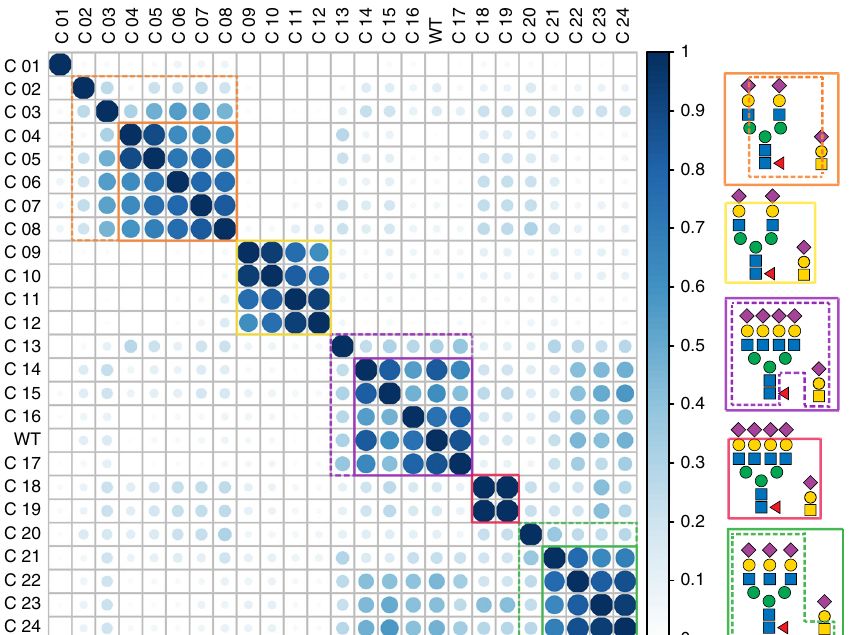
Fig. 2 Clustering of glycoengineered EPO clones based on the correlation between their native MS spectra. In Supplementary Table 1 an overview is given of all 25 clones used, annotating which enzyme(s) was/were knocked-out/knocked-in. Color and size of the circles indicate the similarity between clones where 1 (full circle, dark blue) represents nearly identical EPO glycoproteoform pro fi les. Clusters boxed by full lines represent clones that share high similarity in their pro fi les in terms of N -glycan branching, sialylation and O-glycosylation capacity. Cluster expansions within dashed lines represent clones that display similarity as well as subtle differences in terms of N -glycan sialylation or O-glycosylation capacity. Orange, Green, and Purple boxes represent EPO clones expressing primarily bi-, tri-, or tetra-antennary N -glycans, respectively. Wild Type EPO is denoted as